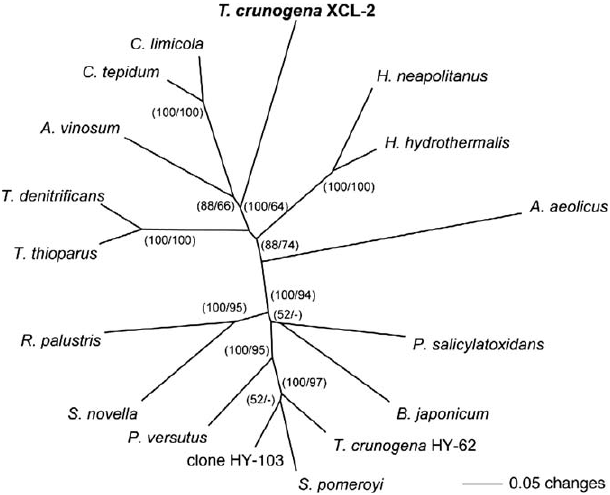
Figure 4. Phylogenetic Relationship of Thiom. crunogena XCL-2 SoxB to Sequences of Selected Bacteria Sequences were aligned using the program package MacVector. Neighbor-joining and parsimony trees based on the predicted amino acid sequences were calculated using PAUP 4.0b10 [113]. Bootstrap values (1,000 replicates) are given for the neighbor-joining (first value) and parsimony analyses (second value). DOI: